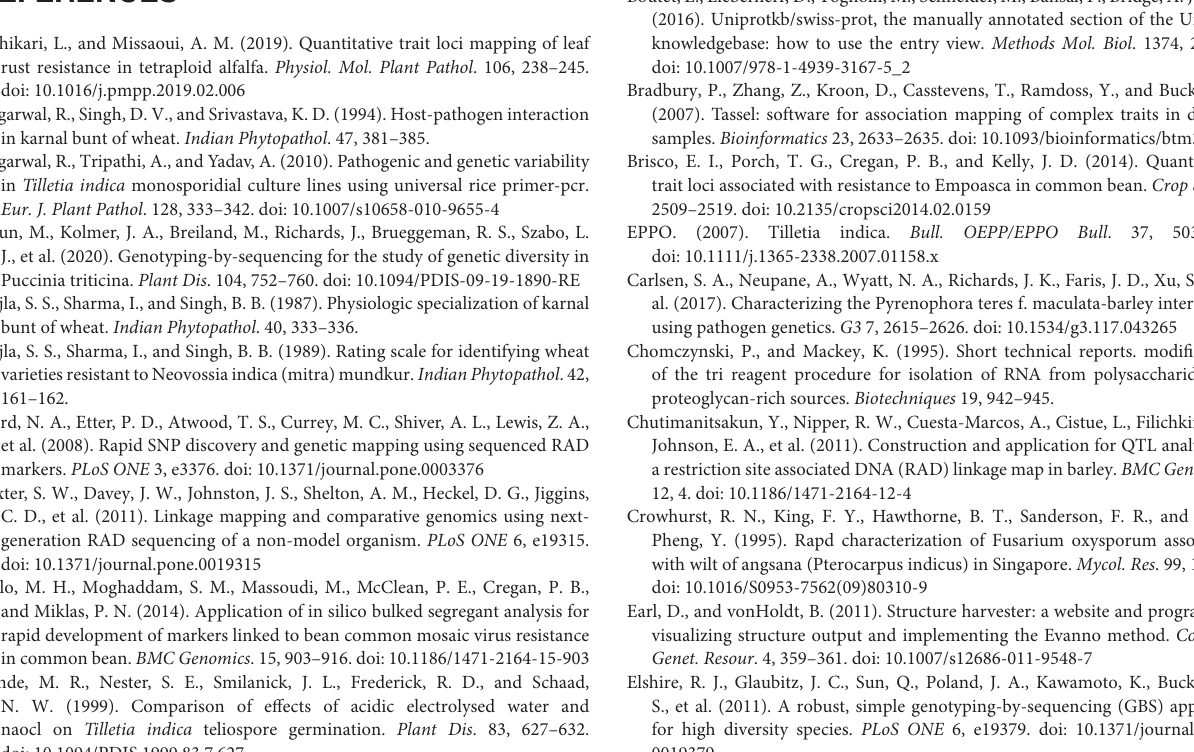
Supplementary Table S1 | Isolates collection location and virulence analysis.